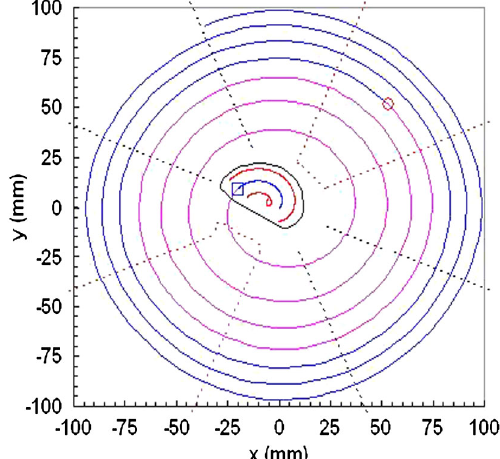
FIG. 14. The spiral inflector, the projection of the injected beam on the median plane, and the initial few turns are shown. The inflector exit is indicated by a square. The injected orbit is matched to the outer orbit at 0.8 MeV (red circle).